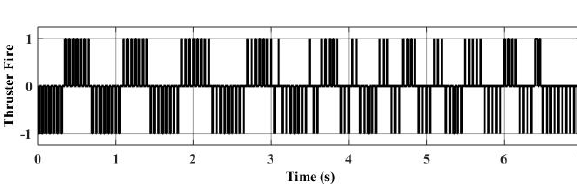
Figure 5. Inverted pendulum simulation—thrust output.